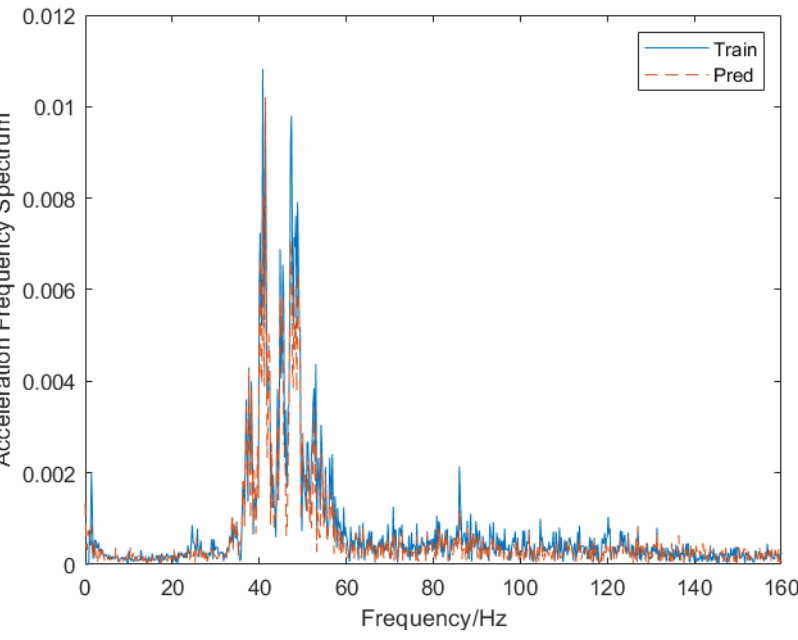
Figure 16. Training results from Channel 7 using processed data.